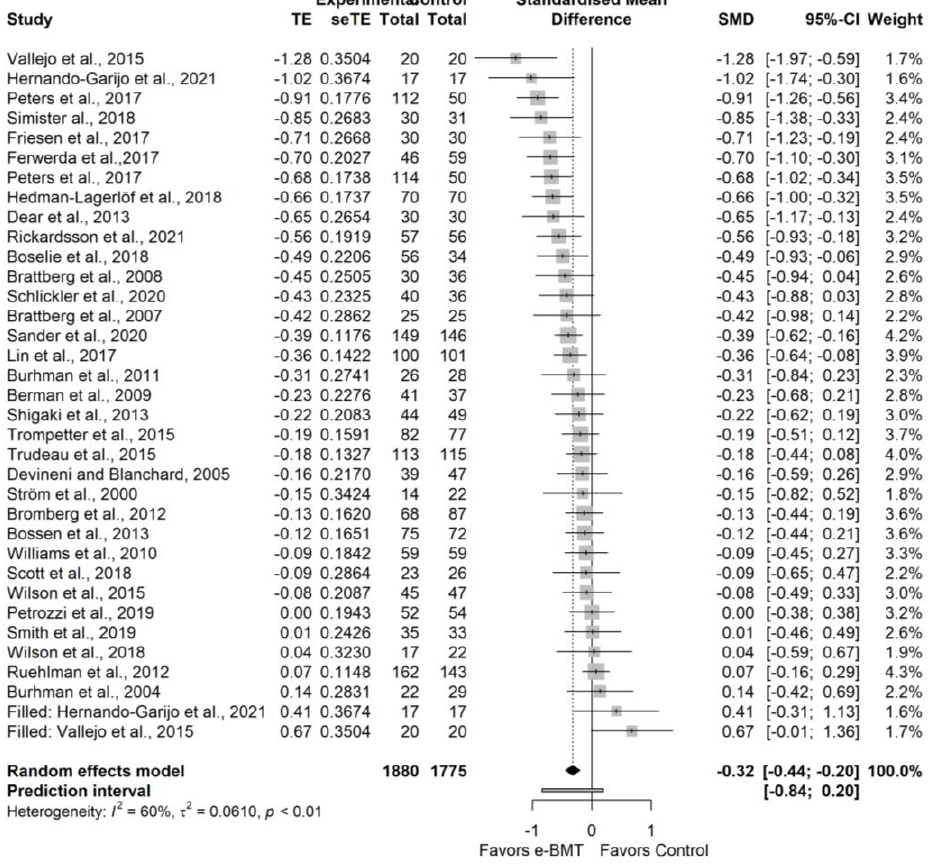
Figure A10. Forest plot of the studies included in the sensitivity analysis and the studies filled to adjust for publication bias.